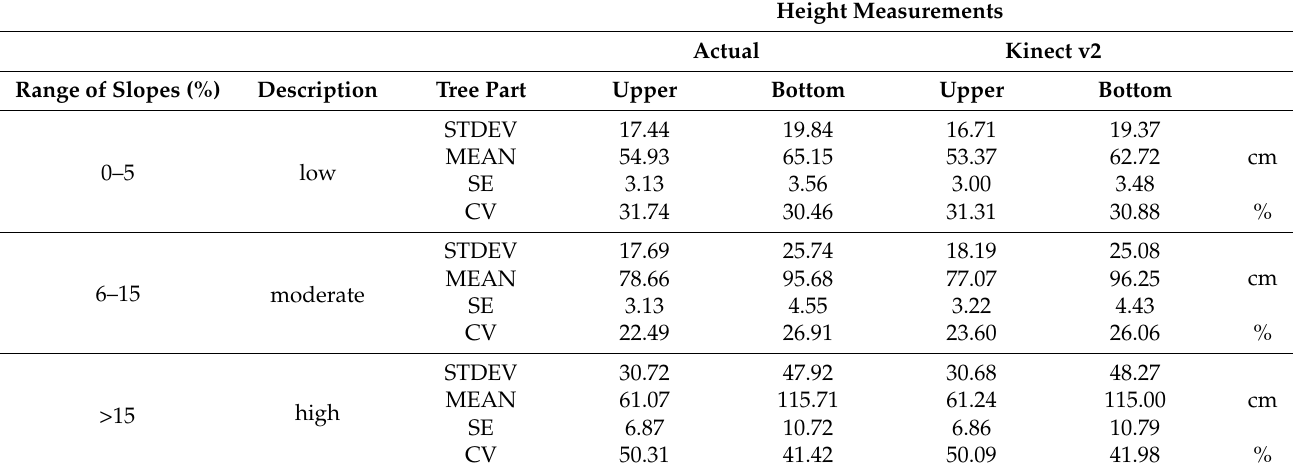
Table 1. Descriptive statistics of the three main categories according to the slope gradient in percentages. Height Measurements Actual Kinect v2